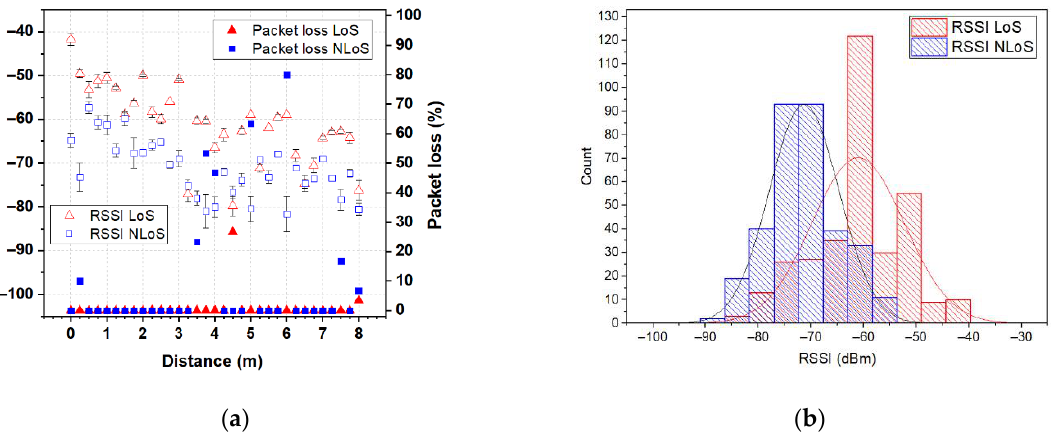
Figure 14. RSSI and packet loss for the backpack-integrated antenna prototype in the case of a backpack with a package of copy-printer paper: ( a ) distributions with respect to the distance between the antennas; ( b ) histograms. The RSSI and packet loss for all positions in the LoS scenario are displayed with red triangles. The RSSI and packet loss for all positions in the NLoS scenario are displayed with blue squares.